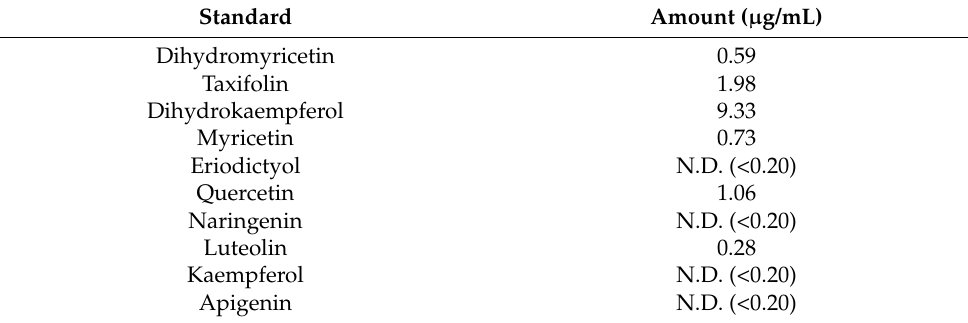
Table 1. Measured flavonoid contents and results of the malanto extract.